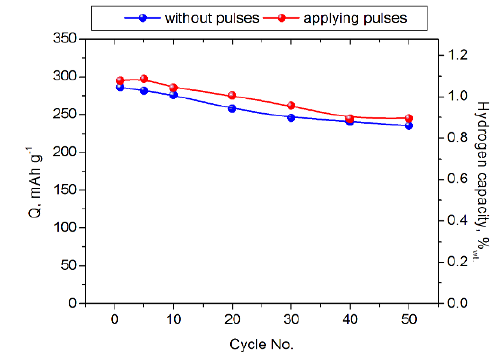
Figure 4. Galvanostatic discharge (+200 mA g -1 ) of electrosorbed hydrogen in the temperature range from 25 o C to 60 o C. Charging was performed at -5 A g -1 (500 mAh g -1 )